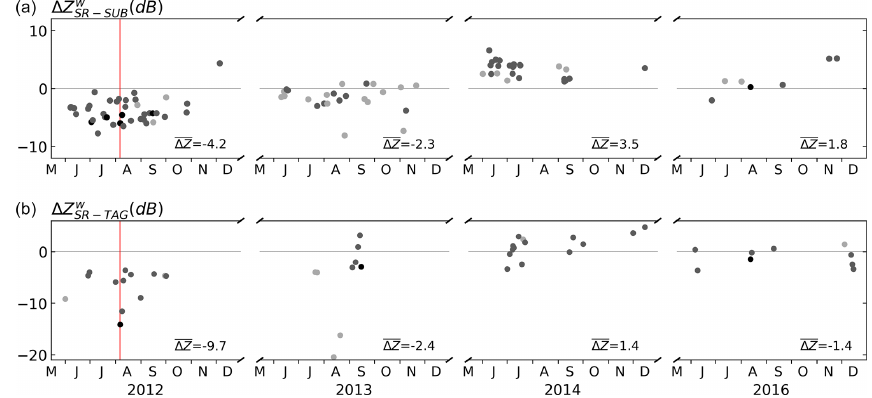
Figure 5. Calibration biases derived from comparison of GR with SR for SUB (a) and TAG (b) for the wet seasons (June to December) of the entire dataset. Symbols are colored according to the number of matched samples, i.e, light grey: 10–99; medium grey: 100–999; and black: 1000+. The red line marks 6 August 2012 for the case study presented in Fig.